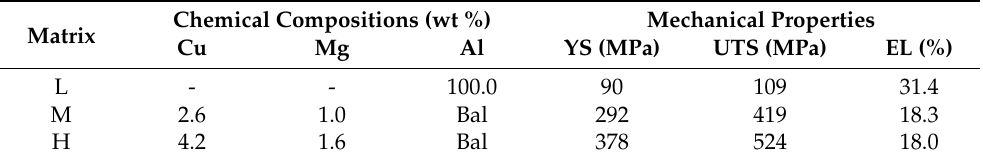
Table 1. Chemical compositions and mechanical properties of the matrices. YS, yield strength; UTS, ultimate strength; EL,